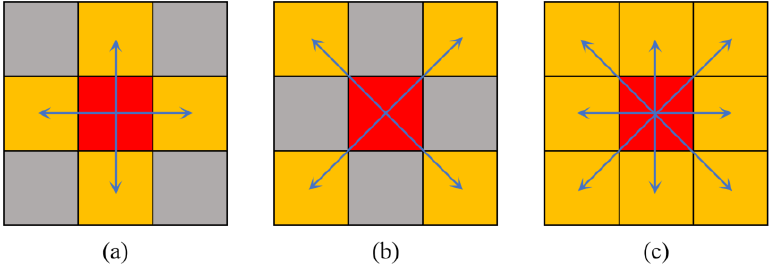
Figure 3. Common neighboring configurations for the weight matrix: ( a ) Rook ’ s case; ( b ) Bishop ’ s case; ( c ) Queen ’ s case.